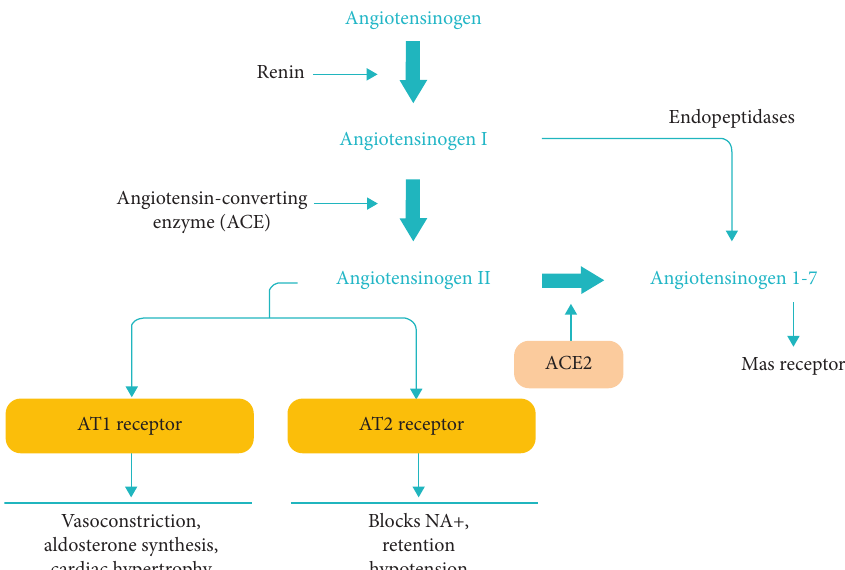
Figure 3: ACE signaling pathway and ACE-mediated physiological responses. Taken from Santos, R. A. S., Ferreira, A. J., Verano-Braga, T., et al., J. Endocrinol. 216, R1-R17,